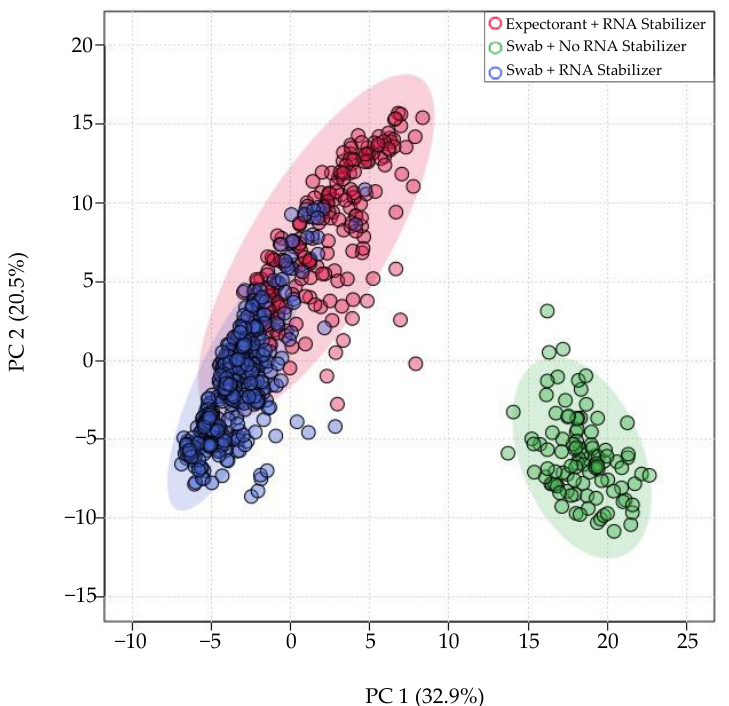
Figure 1. Differences in RNA stabilizer introduce greater miRNA expression variation than differ- ences in method of collection. PCA plot of samples collected with expectorant and RNA stabilizer (red), swab and no RNA stabilizer (green), and swab with RNA stabilizer (purple).